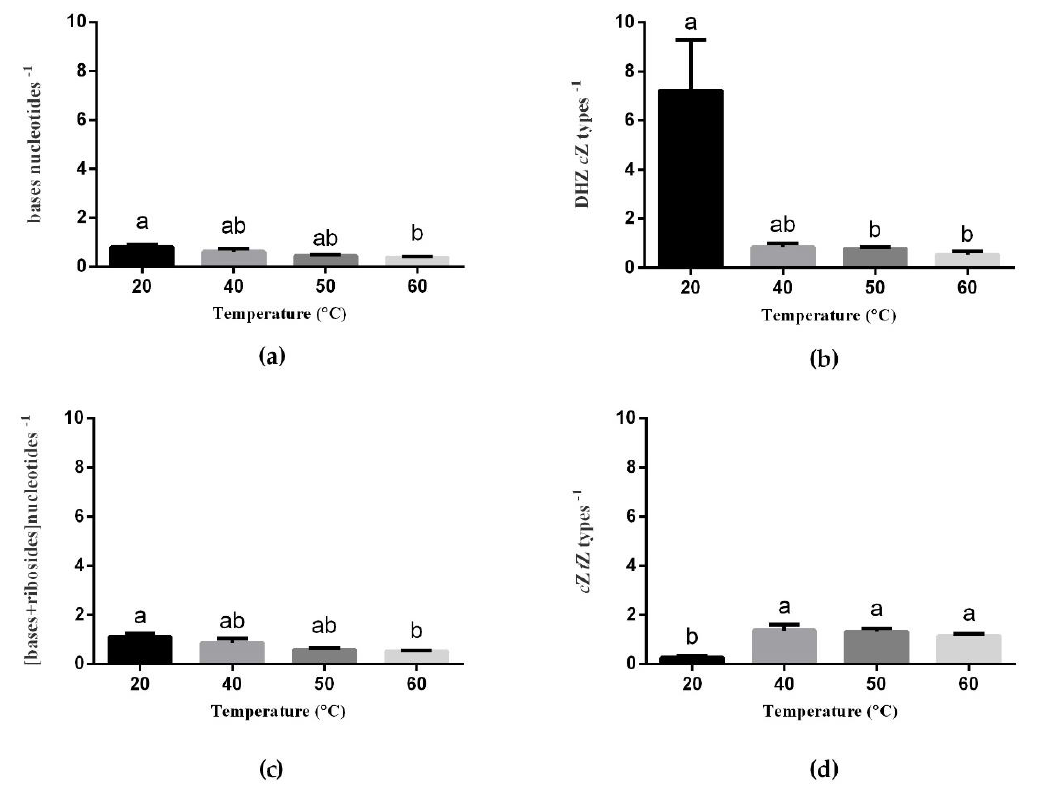
Figure 8. Effect of different temperatures (23 ° C, 9 weeks; 40 ° C, 4 h; 50 ° C, 30 min; 60 ° C, 5 min) at the ratios between endogenous concentrations (pmol g −1 FW± SE) of ( a ) CK bases and CK nucleotides; ( b ) DHZ and c Z types; ( c ) [bases + ribosides] and nucleotides; ( d ) c Z and t Z types. Table 6. Concentration of endogenous isoprenoid cytokinins (pmol g − 1 FW) of P. halepensis embryogenic masses collected at the end of initiation phase and induced under di ff erent temperatures. Treatment